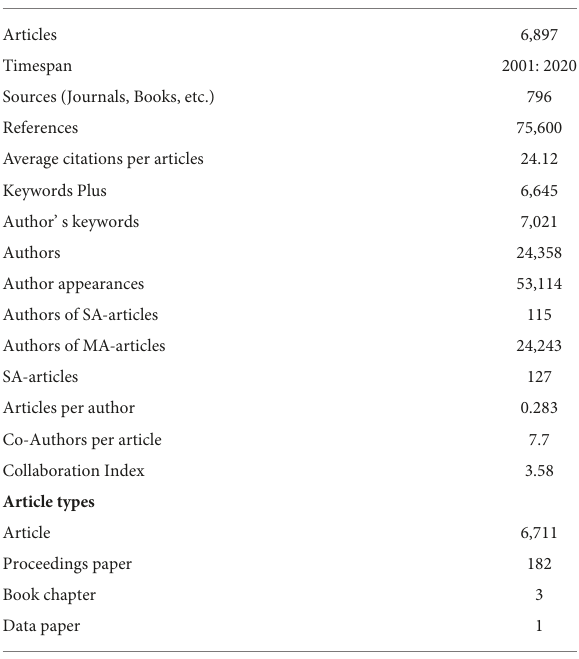
TABLE 1 Summary of the bibliometric characteristics for articles in ventricular arrhythmia